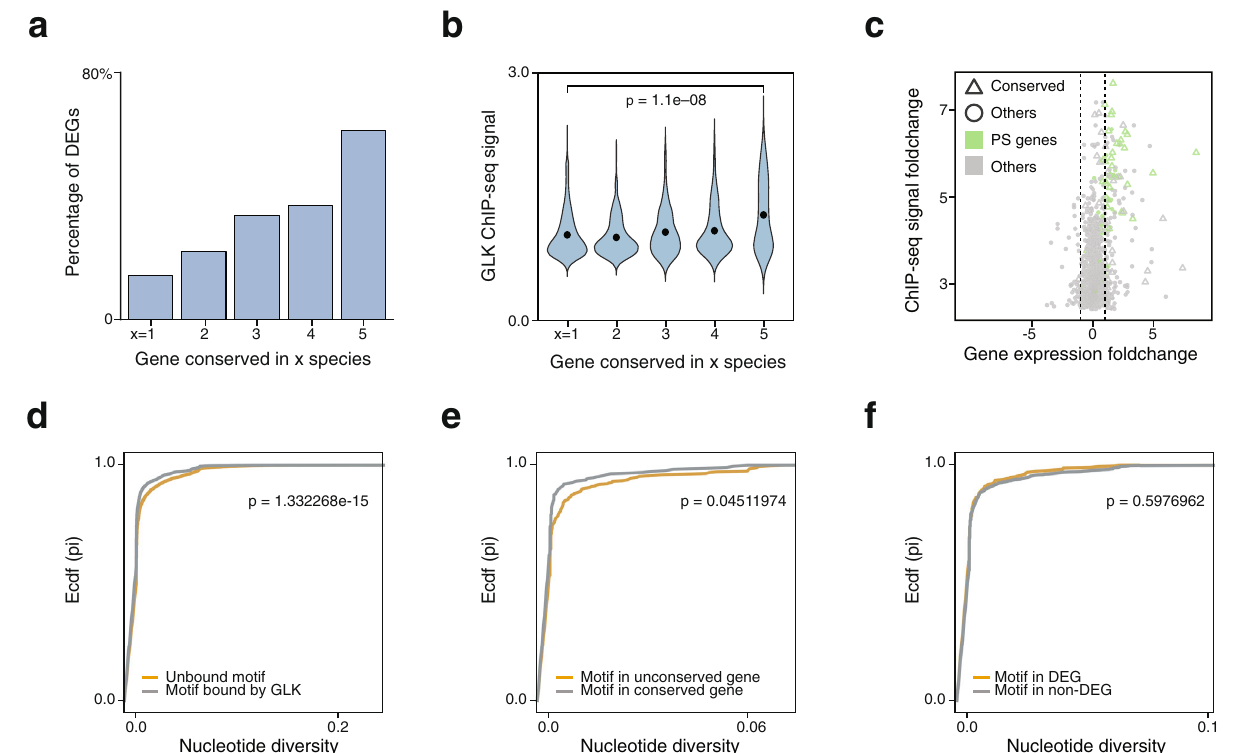
Fig. 5 | Expression of the conserved GLK ChIP-seq target genes. a The most conserved Arabidopsis GLK ChIP-seq targets genes are often differentially expres- sed genes in the GLK mutants. Target genes are divided into fi ve groups based on their conservation level. b GLK binding is stronger in the conserved gene group than in the non-conserved group. The y -axis showed the averaged GLK ChIP-seq signal foldchange (log 10) at the peak summit (Kruskal test). c Volcano plot shows